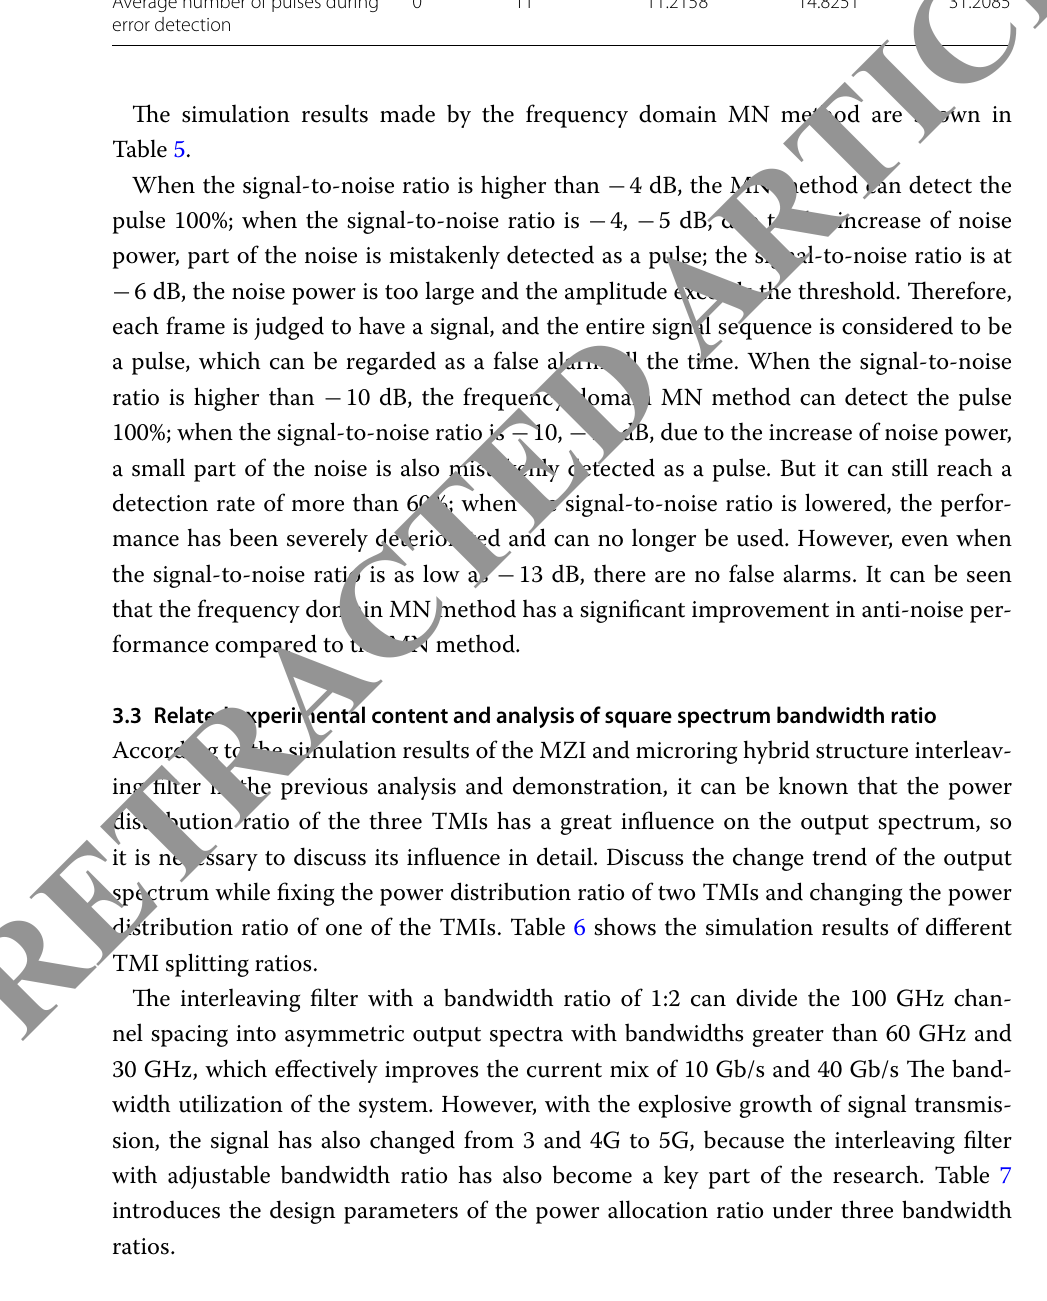
Table 5 Frequency domain MN method detection rate simulation results Signal-to-noise ratio (dB) Average number of pulses during error detection